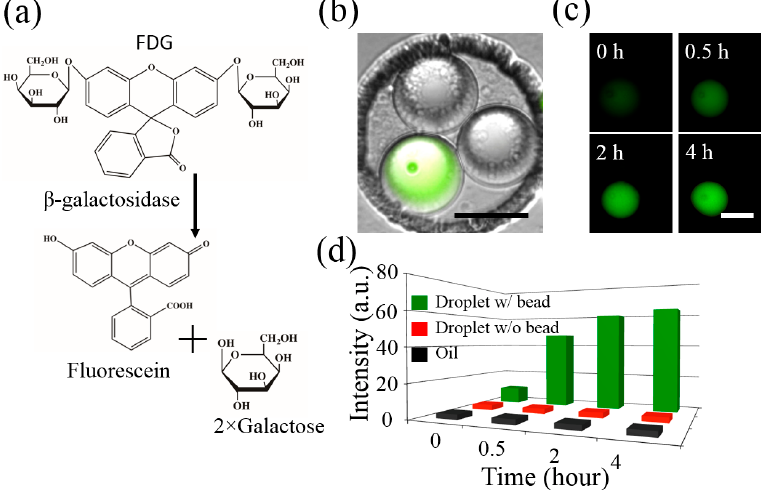
Figure 8. Droplet cross-talk studies of the diffusion of fluorescein between clustered droplets. ( a ) Hydrolysis of FDG by β -gal. ( b ) Microscopic image showing overlay of bright-field and FITC channels for FDG droplets with and without a β -gal bead after a 4-h incubation, scale bar = 50 μ m. ( c ) Fluorescence microscopic images showing time course of reaction over a 4-h incubation to monitor droplet crosstalk, scale bar = 50 μ m. ( d ) Fluorescence intensity of trapped droplets with bead (green), without bead (orange), and the oil phase (black).